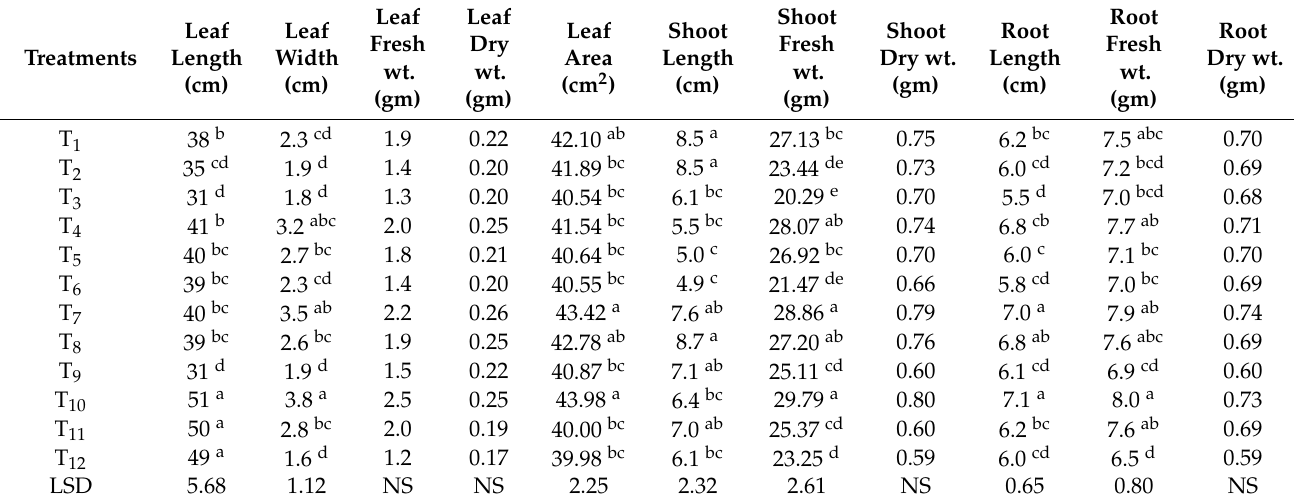
Table 1. Impact of TU–ANPs on vegetative growth parameters of Zea mays L. grown under different levels of NaCl-based osmotic